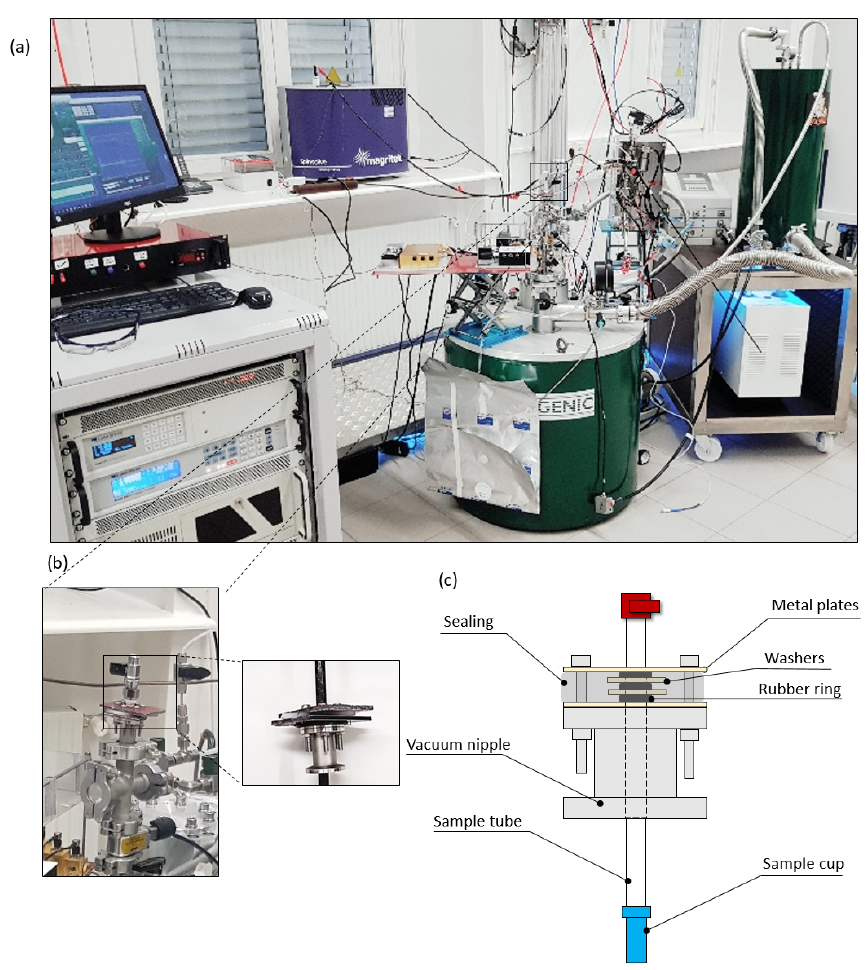
Figure 1. (a) The cryogen-consumption-free DDNP system (green magnet) used together with the proposed hybrid sample handling system. The low-field spectrometer (blue magnet) used here for detection is situated in the back. (b) Close-up of the airlock atop the DDNP system with the vacuum seal attached. The smaller panel shows the detached seal. (c) Scheme of the seal (grey), the sample chamber (blue), and the sample tube (white). An array of washers, a silicon fitting, and O-rings renders the seal vacuum-tight, while the sample stick can be moved vertically. The seal is attached to the airlock atop the DNP system via a vacuum nipple. (Images by Kateryna Che and Ludovica M.